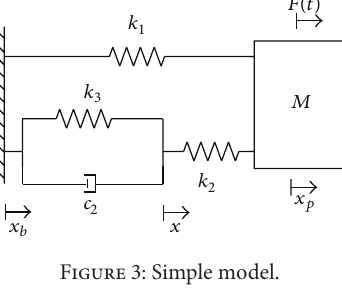
Figure 1: The schematic diagram of a microvibration isolator.